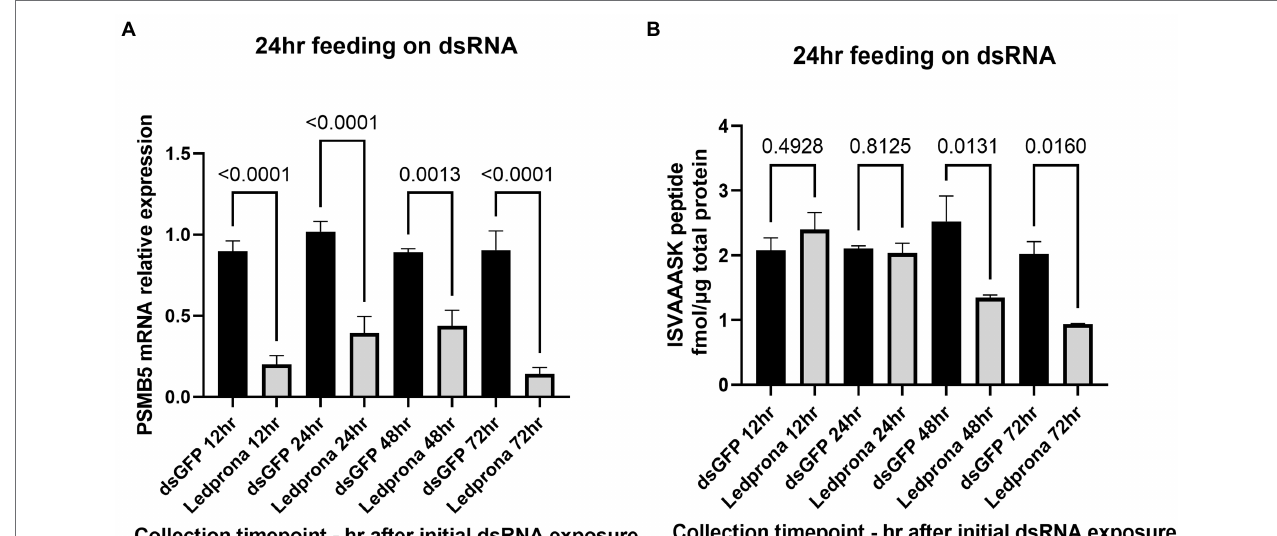
FIGURE 9 | PSMB5 mRNA relative expression (A) and protein level (B) of CPB larvae feeding on Ledprona (or dsGFP) for 24 h and collected over time for silencing persistence analysis. Graph represents the average of biological replicates and error bars denote standard deviations. Values of p are indicated as a result of multiple comparison (Sidak’s multiple comparison test).